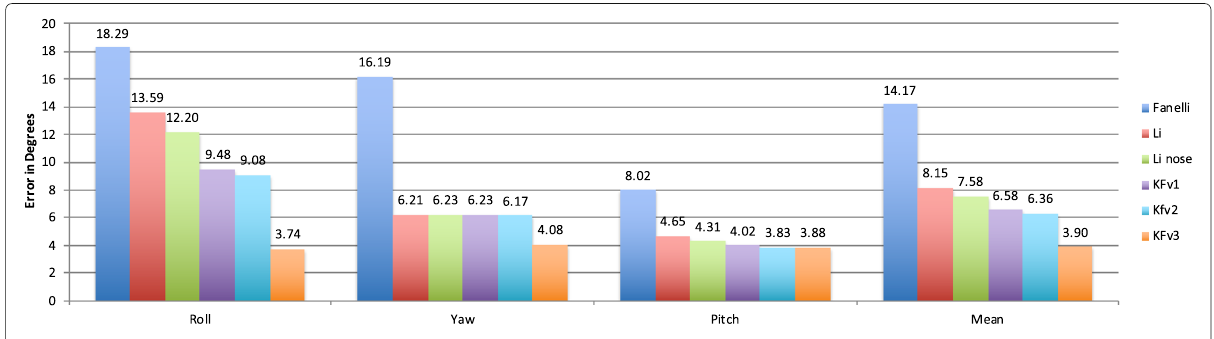
Fig. 12 Mean of the results on the ICU dataset. Mean orientation error (in degrees)